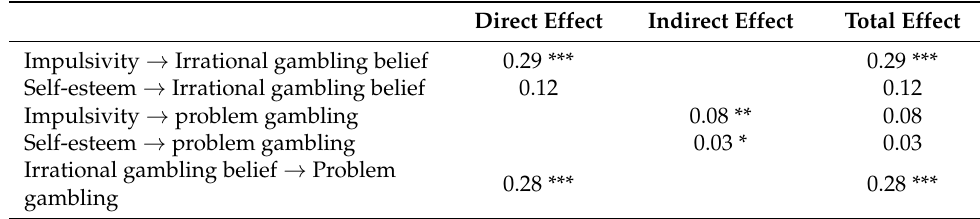
Table 6. Standardized direct and indirect effect.